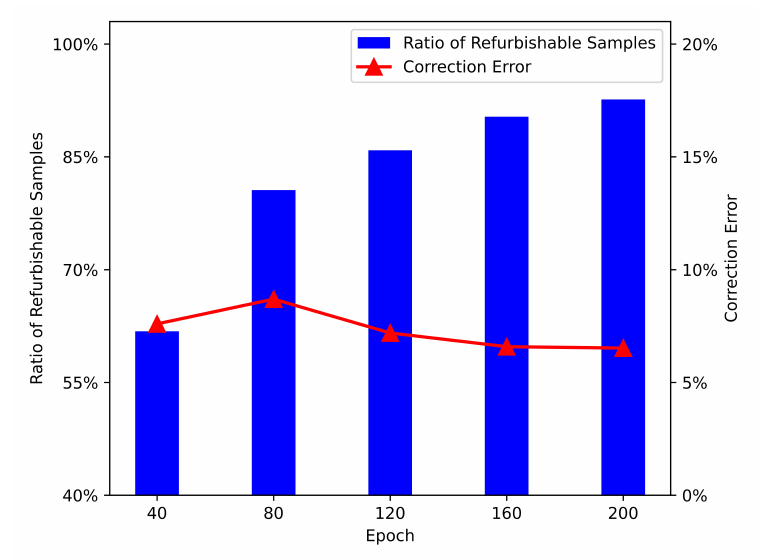
Figure 10. Trend of statistics in history-guided label